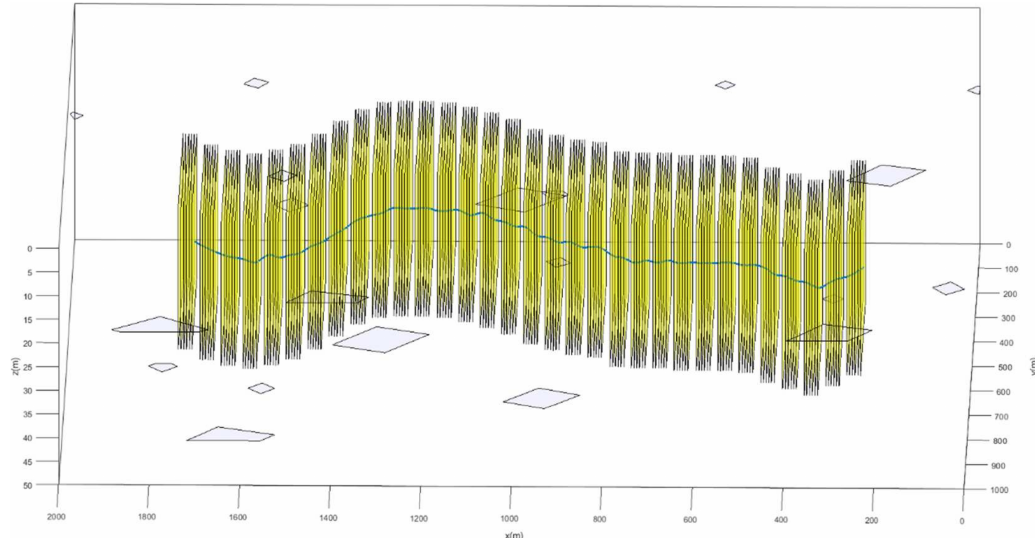
Figure 2. Case well demonstration with both hydraulic fractures and natural fractures.